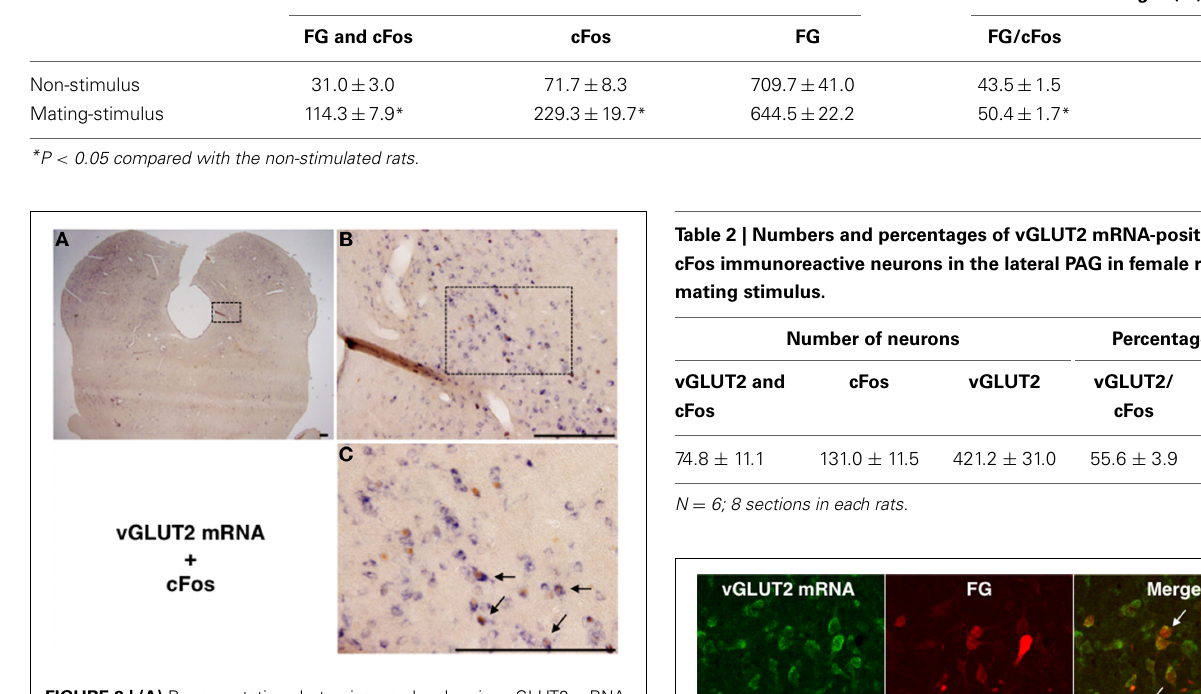
FIGURE 3 | (A) Representative photomicrographs showing vGLUT2 mRNA (purple) in situ hybridization and cFos (brown) immunohistochemistry in the caudal part of the lateral PAG. (B) High magnification of the square in (A) . (C) Enlarged view of several neurons in the square in (B) . Arrows show vGLUT2 mRNA and Fos-ir neurons. Scale bar: 200 μ m.